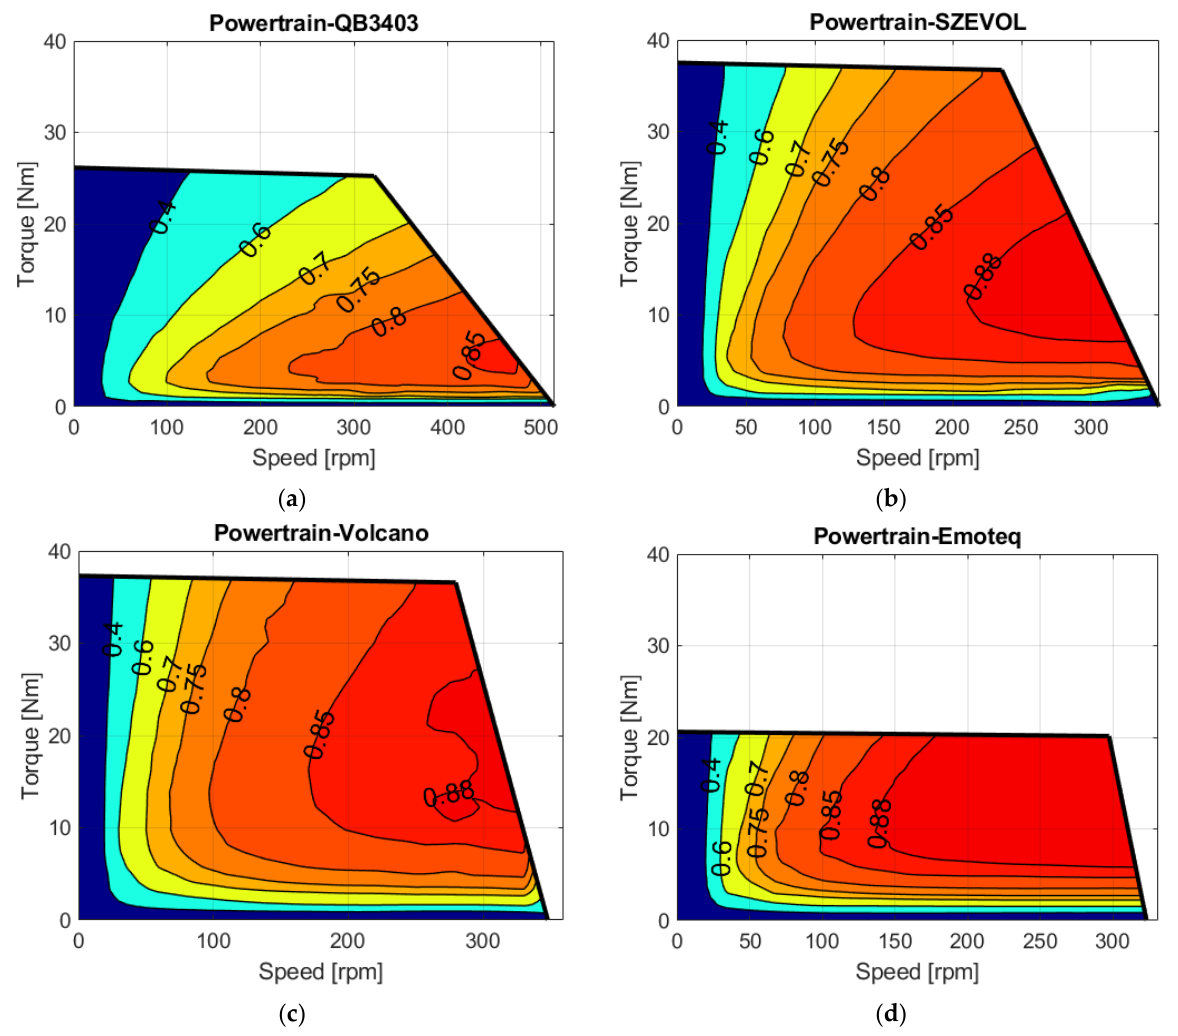
Figure 3. The measured efficiency map of the investigated powertrain, including the efficiency of the controller and transmission: ( a ) QB3403-PMSM; ( b ) SZEVOL-BLDC; ( c ) Volcano-BLDC; and ( d ) Emoteq-PMSM.